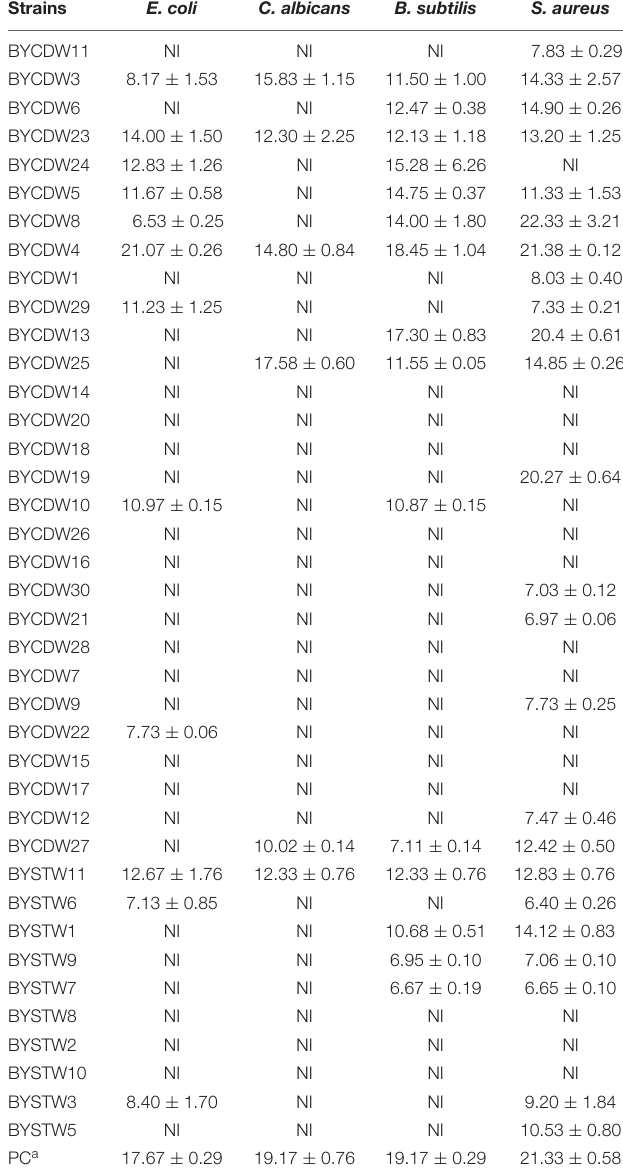
FIGURE 1 | Neighbor-joining phylogenetic tree of ITS rDNA sequences of O. formosanus fungal isolates. Bootstrap values were calculated using 1,000 replications.